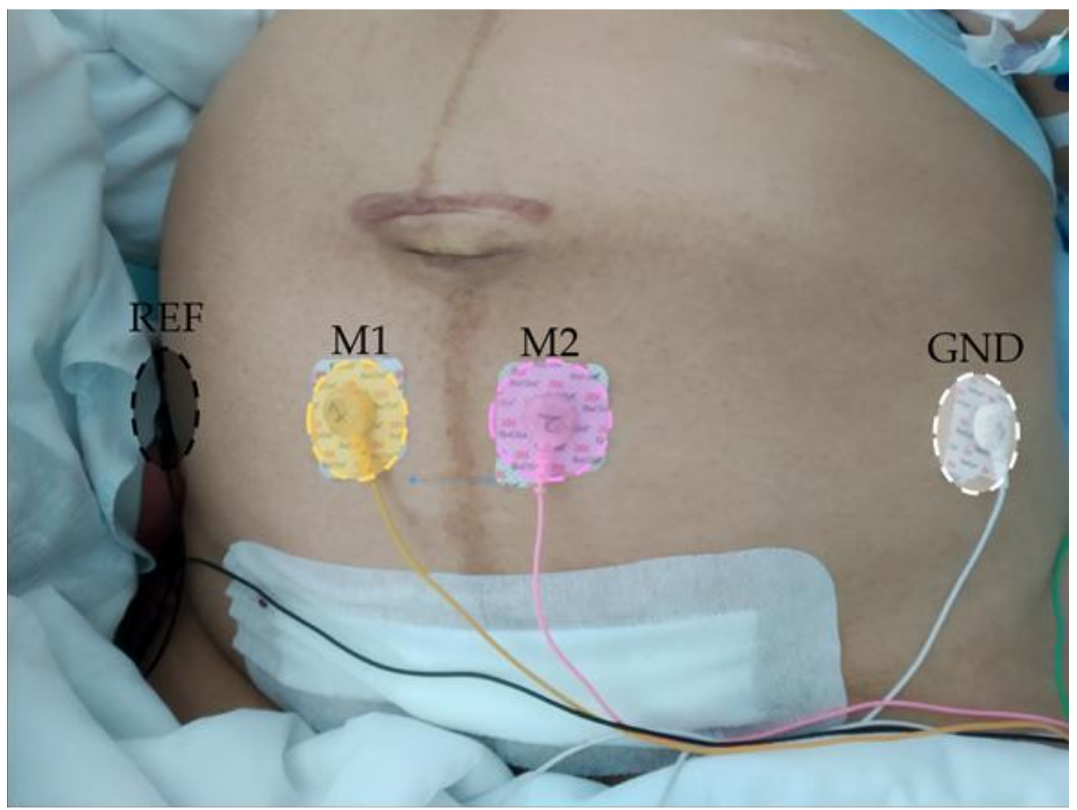
Figure 1. Electrodes positioning for postpartum uterine myoelectrical